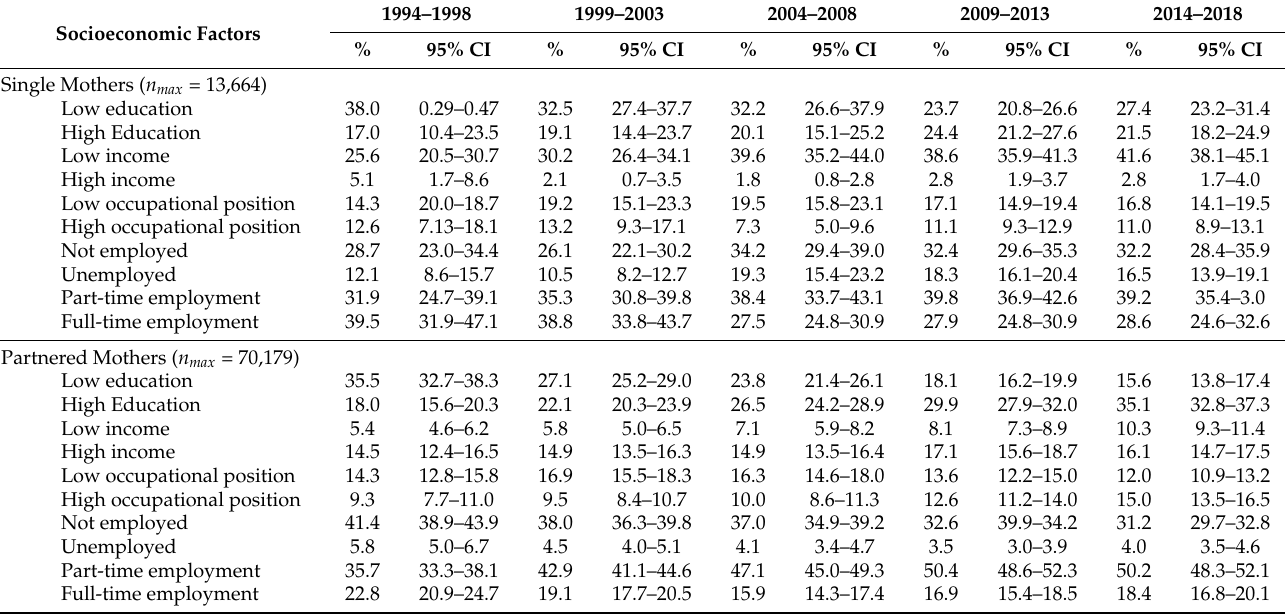
Table 6. Development of socioeconomic factors (predicted probabilities) in single and